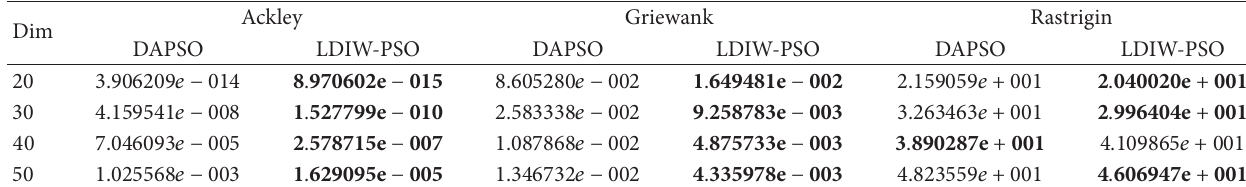
Table 6: Experimental results for LDIW-PSO compared with DAPSO.